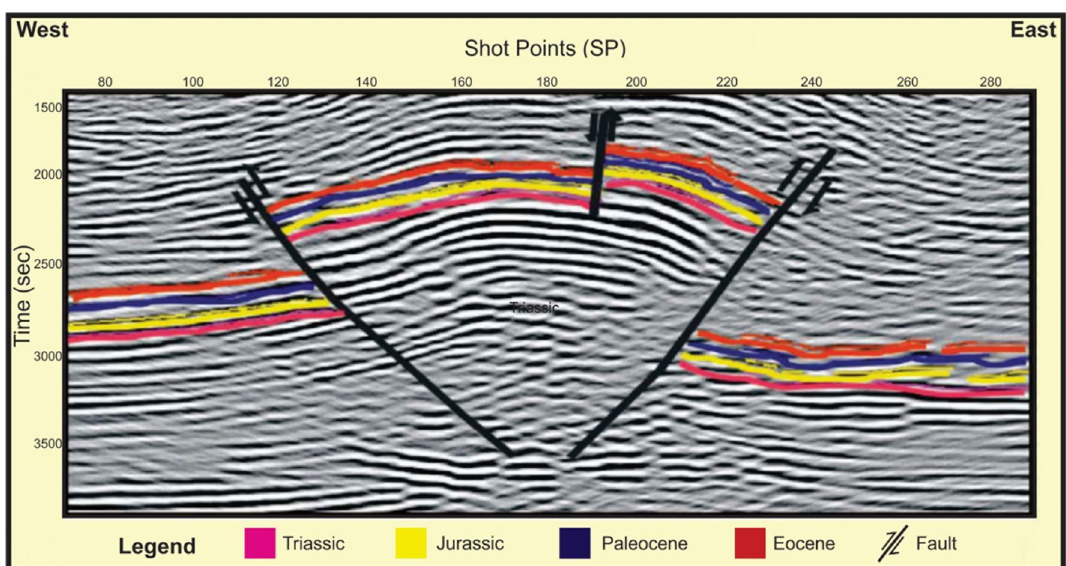
Fig. 2 Seismic section of line S97-MYL-06 showing pop-up structure in the Meyal Oil Field, Potwar Sub-basin, Pakistan (modified after Hasany and Saleem 2012; Ghazi et al. 2014)